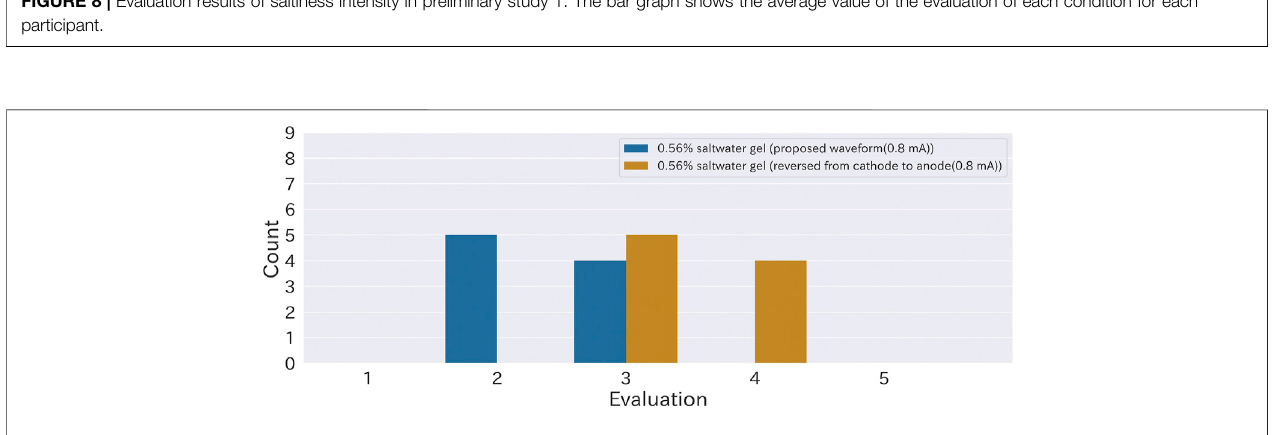
FIGURE 9 | Evaluation results of discomfort for each condition in the preliminary experiment 1. The numerical values indicate 1: none, 2: low (not bothersome), 3: mild (bothersome in daily life, but not unbearable), 4: moderate (bearable in testing, but unbearable in daily life), and 5: severe (unbearable).